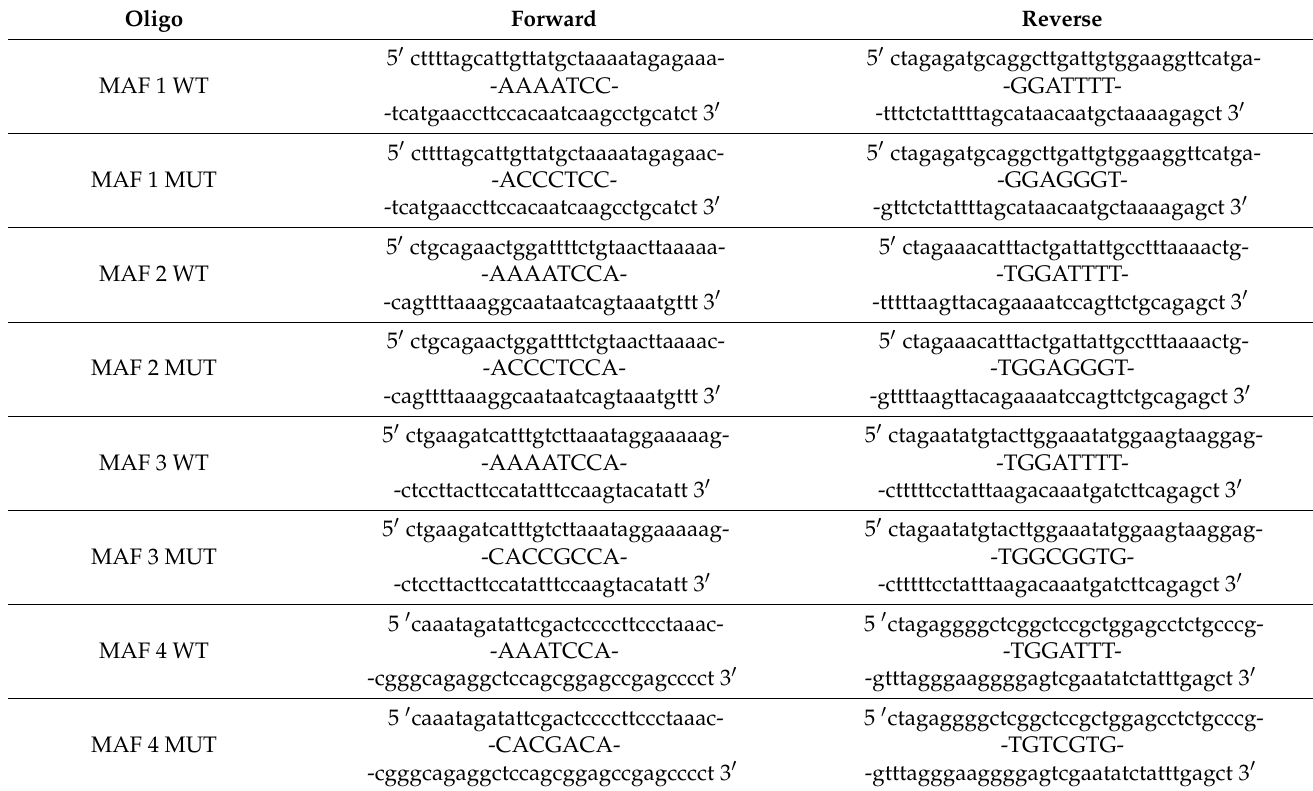
Table 2. Sequences of oligonucleotides cloned to the pmirGLO Dual-Luciferase miRNA Target Expression Vector. The consensus motif recognized by the miRNA seed region is shown in capital